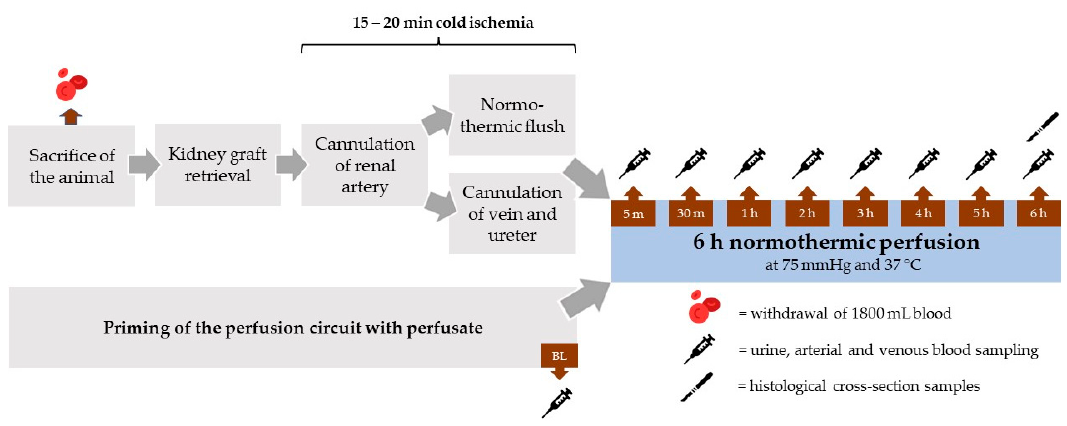
Figure 1. Schematic overview of the experimental procedure.